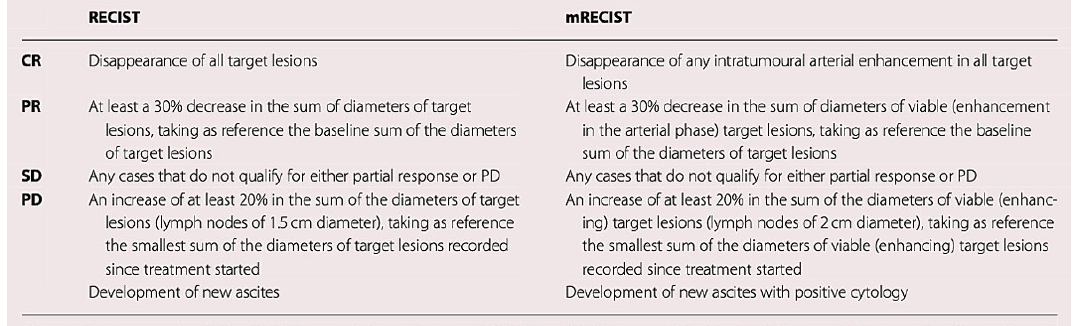
Figure 4: Response assessment by RECIST v1.1. and mRECIST for HCC. Reproduced with permission from the European Society for Med- ical Oncology (ESMO) clinical practice guidelines